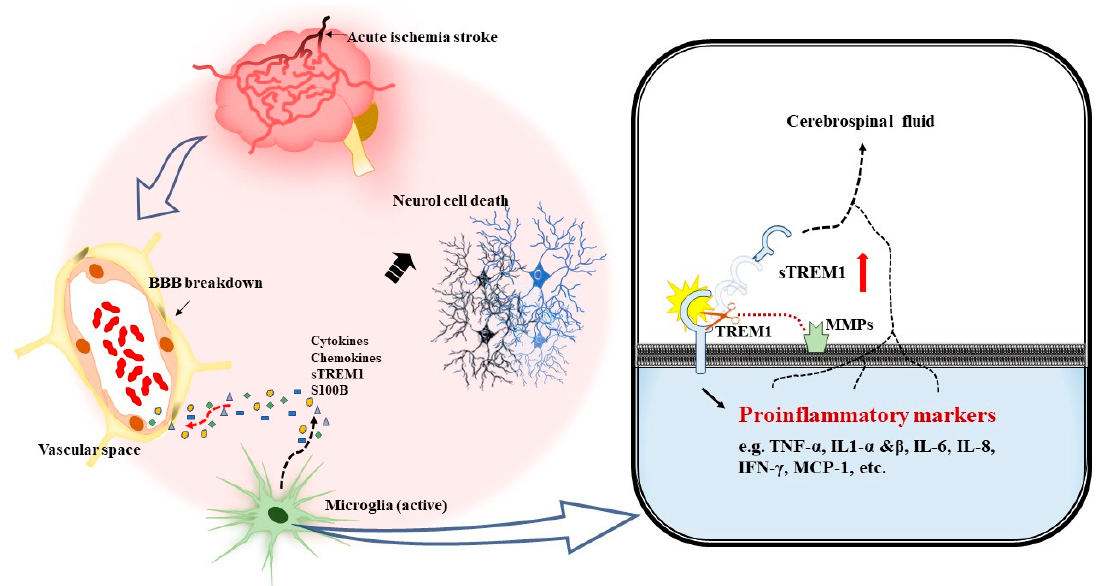
Figure 2. Schematic diagram illustrating the proposed triggering receptor expressed on the myeloid cells-1 (TREM-1) signaling pathway involved in downstream inflammatory machinery, which contributes to acute ischemic neuronal cell death. Acute ischemic stroke may cause ischemic brain cell death, which is influenced by the amount of human S100 calcium-binding protein B (S100B). Acute ischemic insult is a danger signal, which activates soluble TREM-1 (sTREM-1) from the shedding of membrane TREM-1 in activated glial cells, promoting an increased production of proinflammatory cytokines/chemokines in cerebrospinal fluid and leakage to serum from disrupted BBB. TNF- α : tumor necrosis α , IL-1 α : interleukin 1 α , IL-1 β : interleukin 1 β IL-6: interleukin 6, IL-8: interleukin 8, IFN- γ : interferon- γ , MCP-1: monocyte chemoattractant protein-1, MMPs, matrix metalloproteinases.